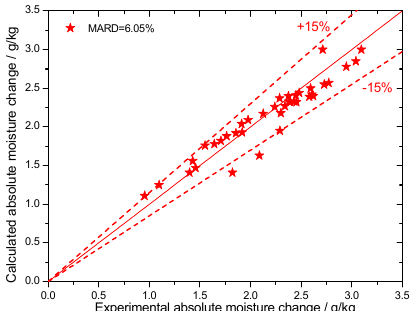
Figure 8. Comparison of experimental and calculated absolute moisture